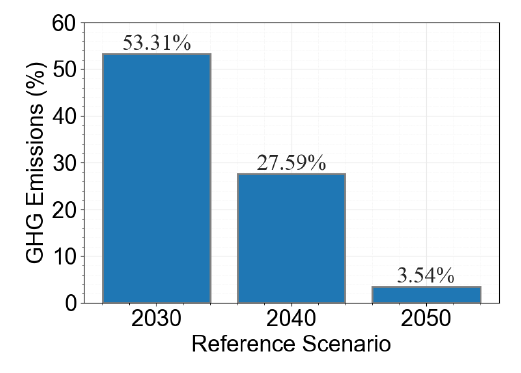
Figure 6. BAU—Evolution of GHG emissions for the residential sector (%).